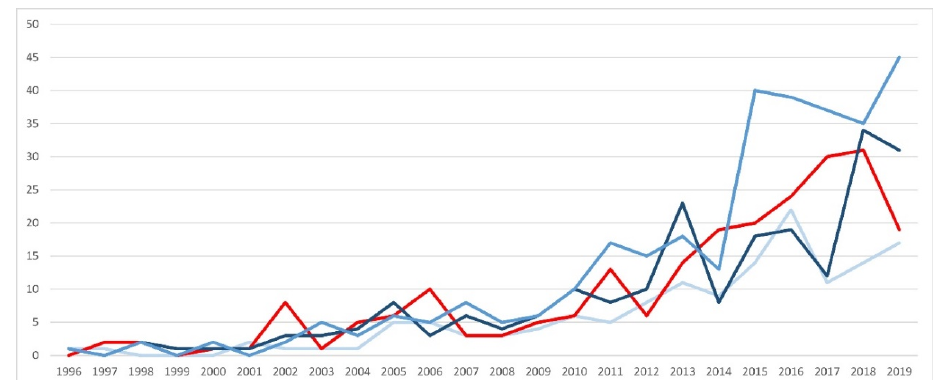
Figure 9. Temporal evolution (1996–2019) of FRAs references (number of records) in WoS databases classified by hydrologic–hydraulic methodologies: red line, flood frequency analysis; clear blue, rainfall–runoff transformation; middle blue, hydrologic modeling; deep blue, hydraulic modeling.